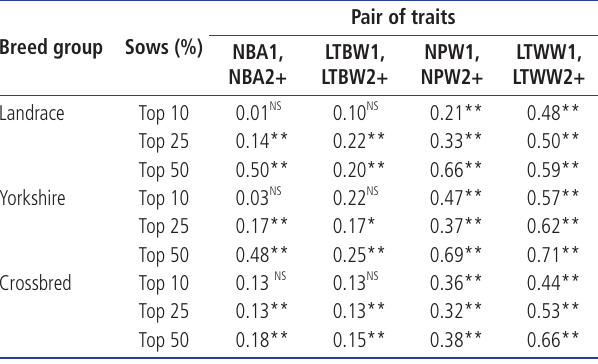
Table 6. Spearman rank correlations between EBV for first parity and sums from second to last parity reproduction traits for the top 10%, 25%, and 50% of sows Pair of Breed group Sows (%)